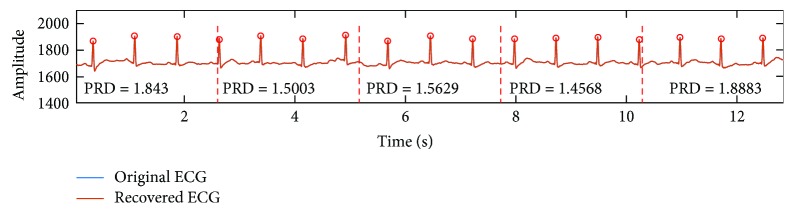
The recovered signal with 10 points delay.